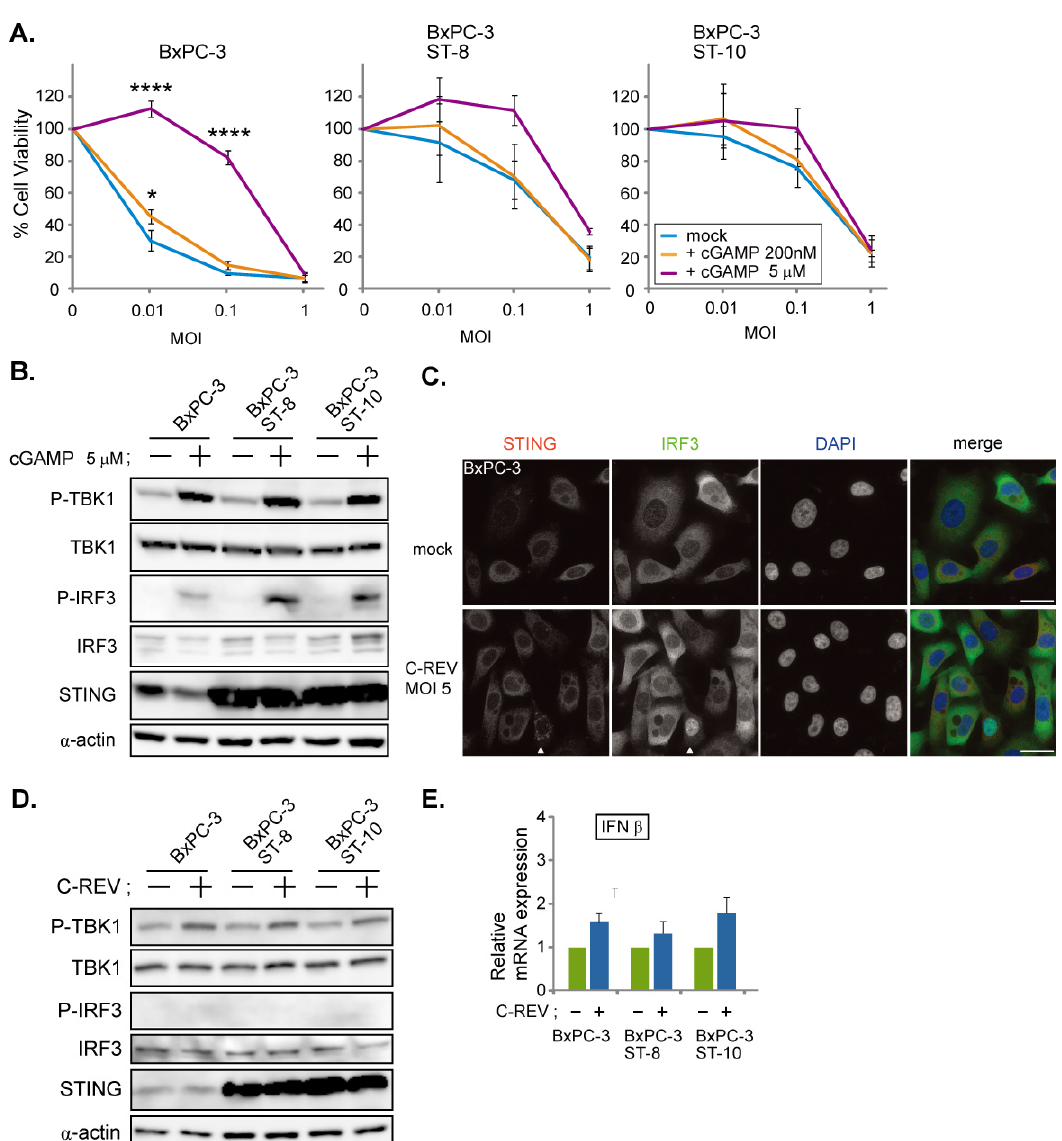
Figure 3. C-REV suppresses STING activation in BxPC-3 cell line. ( A ) Cytotoxicity of C-REV with indicated MOI against BxPC-3, BxPC-3 ST-8 and BxPC-3 ST-10 cells on day 3 by MTT assay. Cells were treated with digitonin and 2 ′ 3 ′ -cGAMP (200 nM or 5 μ M) for 1 h before viral infection. Data are presented as mean ± SEM of 3 independent experiments. ( B ) Western blot analysis on the indicated proteins on the STING pathway after treatment with digitonin and 2 ′ 3 ′ -cGAMP (5 μ M). ( C ) Images of BxPC-3 cells infected with C-REV (MOI 5) at 6 hpi. Cells were stained with anti IRF3 antibodies and anti-STING antibodies. Arrowheads depict cells with stacked STING and with intranuclear translocation of IRF3. Scale bar represents 20 μ m. ( D ) Western blot analysis on the indicated proteins on the STING pathway. The indicated cells were lysed at 6 h after infection with C-REV (MOI 5). ( E ) Induction of IFN β was analyzed by RT-qPCR on the indicated cells infected with C-REV (MOI 5) at 6 hpi. IFN β expression was normalized relative to the expression of the G3PDH protein. Data are presented as mean ± SEM of 3 independent experiments. * p < 0.05, **** p < 0.0001.